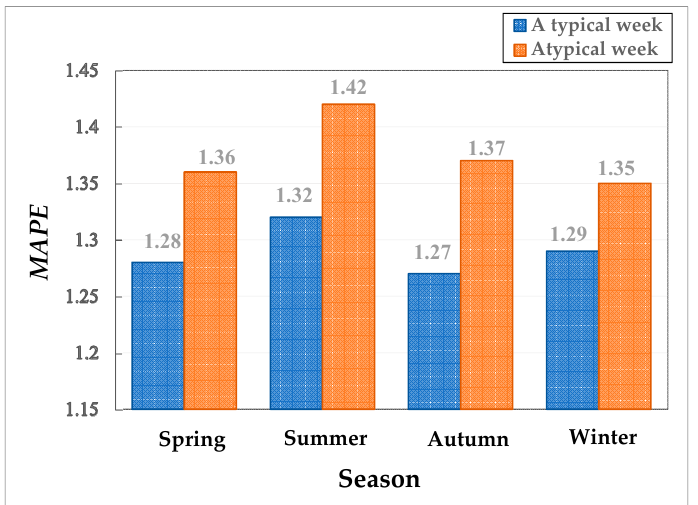
Figure 10. A comparison of MAPE , a typical week and an atypical week’s average load forecast for the four seasons of 2020. Table 2. The average MAPE and Max. MAPE of each month was obtained using different